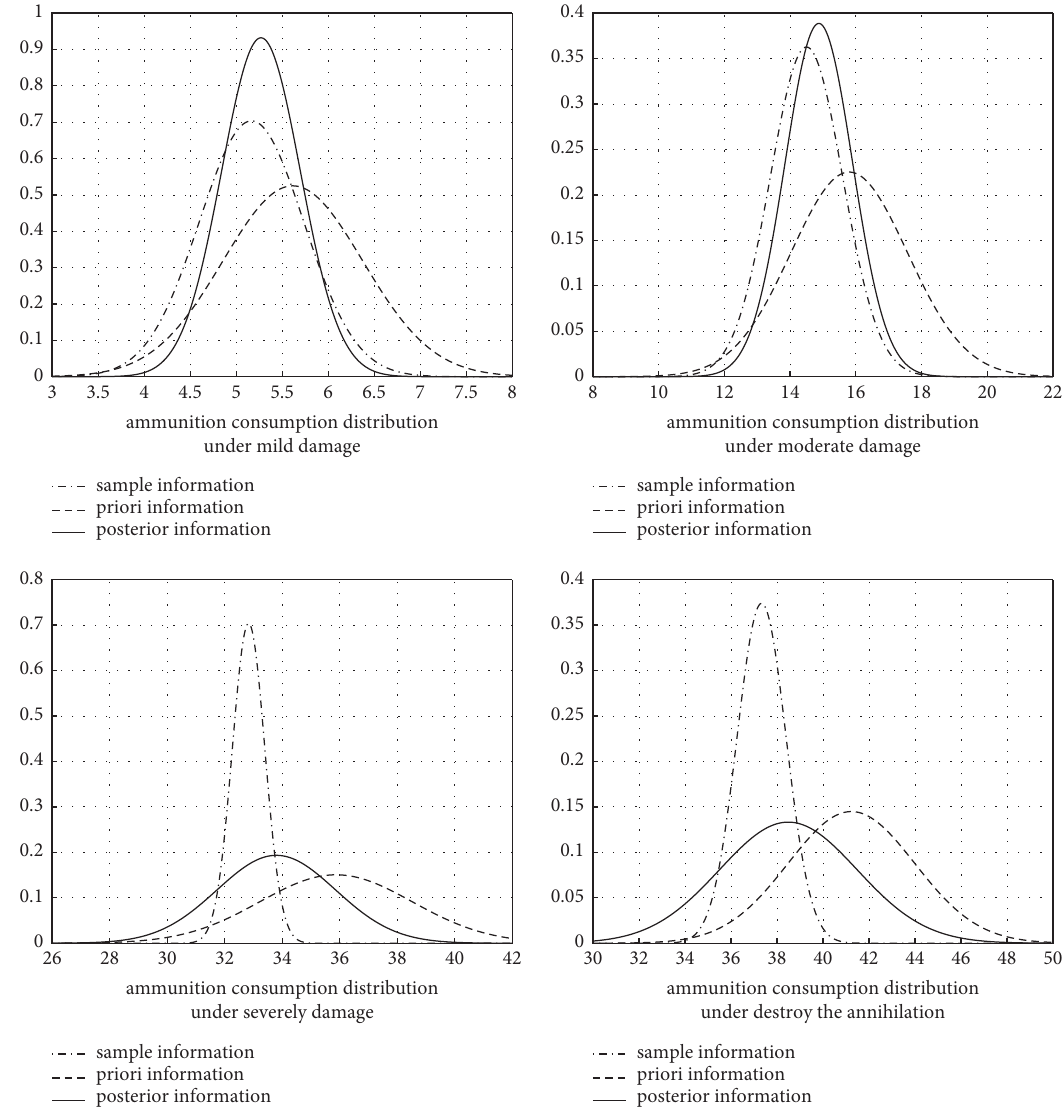
Figure 3: The ammunition consumption distribution diagram of sample information, prior information, and posterior